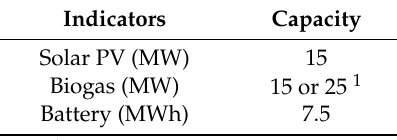
Table 1. Parameters of the case study for the operations of the Day-Ahead and Week Futures markets. The composition of solar PV, BESS, and flexible biogas (BIO) (PV/BESS/BIO) for sensitivity